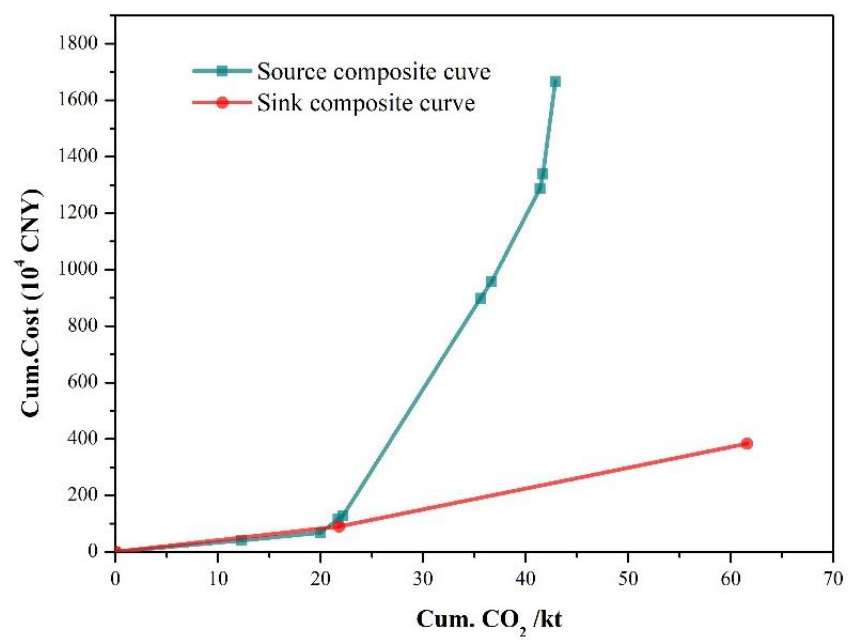
Figure 5. Source – sink curve of the tobacco industry for Scenario 2.